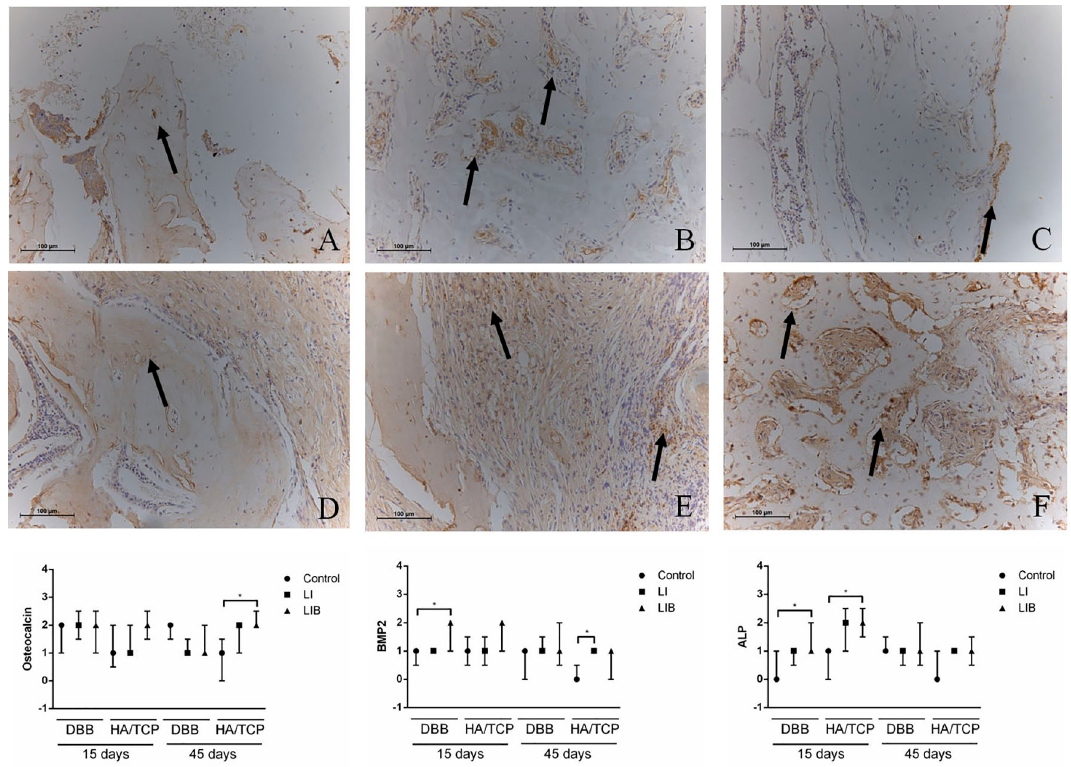
Figure 6- Representative images and graphs of the expression analysis of the OCN, BMP2, and ALP proteins. Protein expression in the non-irradiated groups (A-C). A) OCN at 45 days; B) BMP2 at 15 days; C) ALP at 15 days. Expression of the proteins in the irradiated groups (LI and LIB) (D-F). D) OCN at 45 days; E) BMP2 at 15 days; F) ALP at 15 days (200x magnification). * p<0.05 - Higher protein expression than the non-irradiated groups. Kruskal-Wallis test complemented by the Dunn